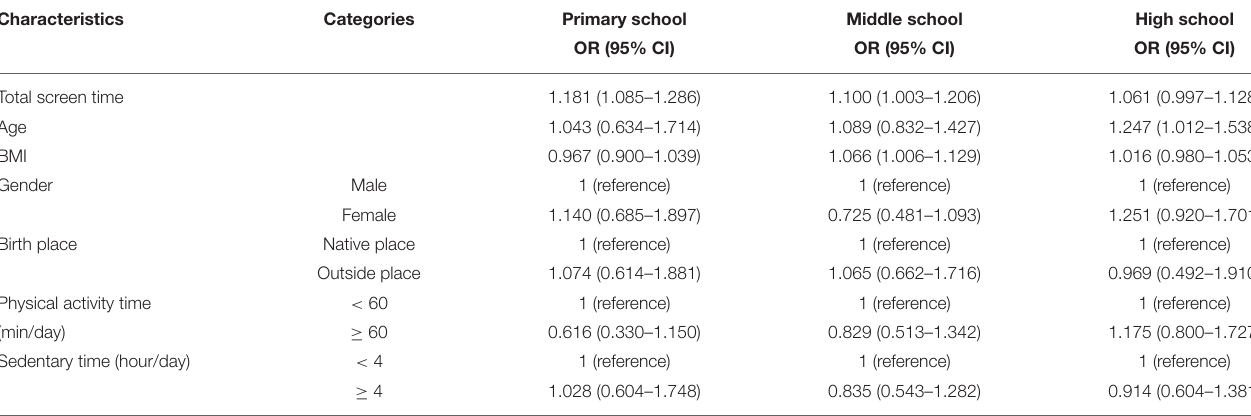
TABLE 5 | Associations between total screen time and the abnormal academic stress stratified by grade group.